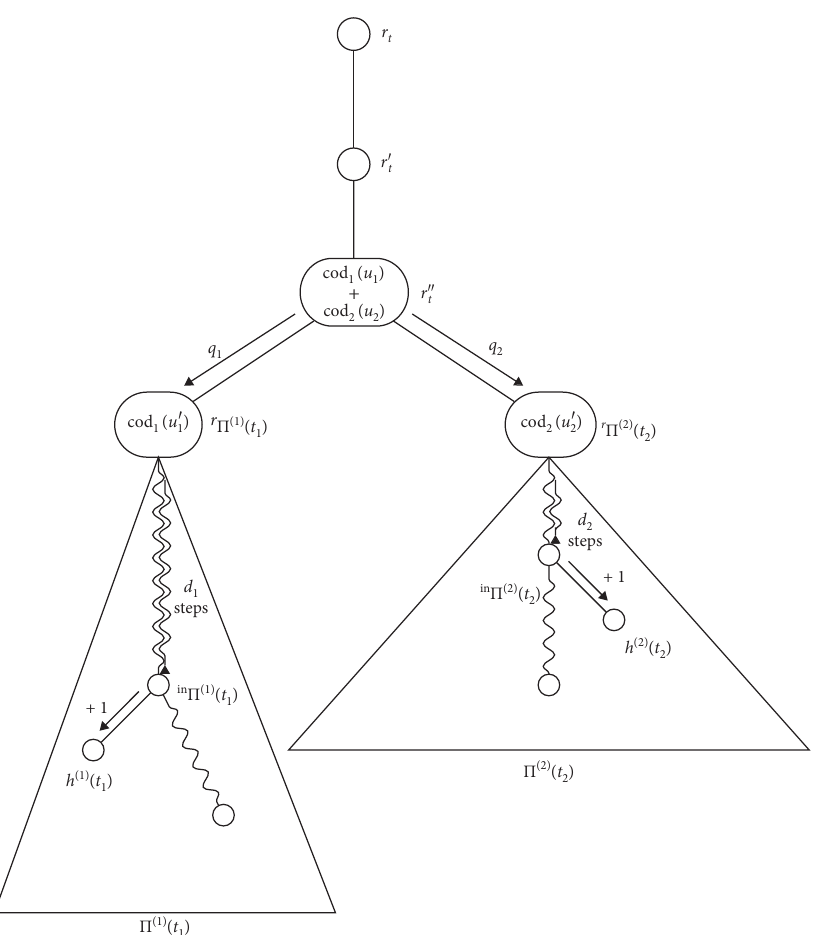
″ to the corresponding in . For this purpose, rules from 1 and 2 are applied. Besides these rules, t Π ( i ) ( t i ) be available in their corresponding membranes only when objects from Σ ( t ) are in h